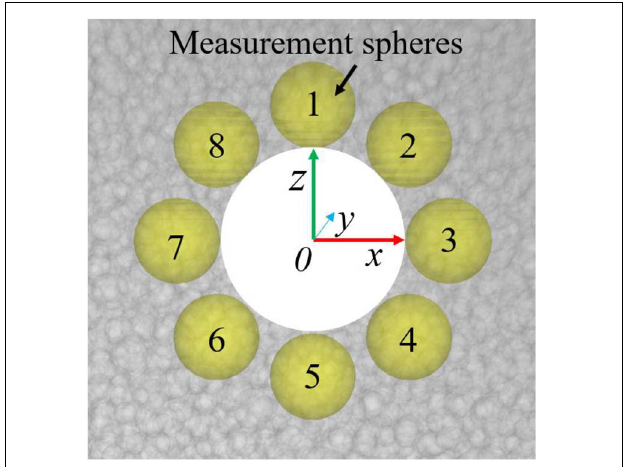
FIGURE 9 | Arrangement of measurement spheres (measurement spheres around a circular